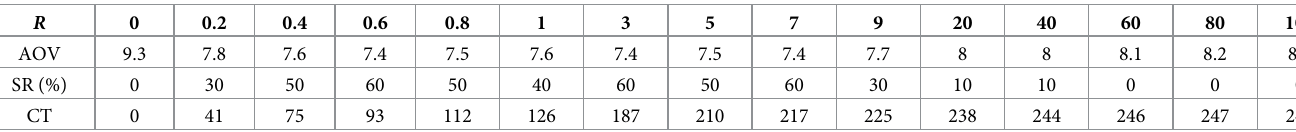
Table 5. Values of AOV, SR, and CT for different values of R